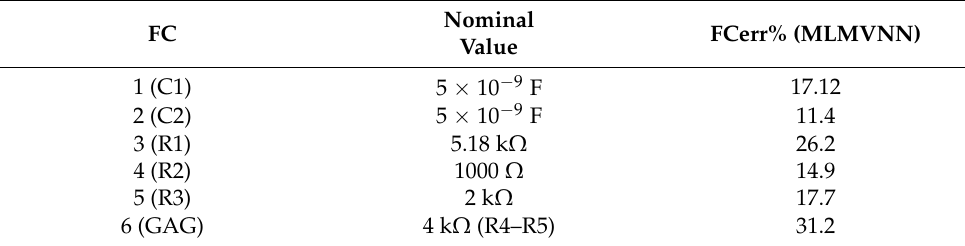
Table 2. Fault component identification